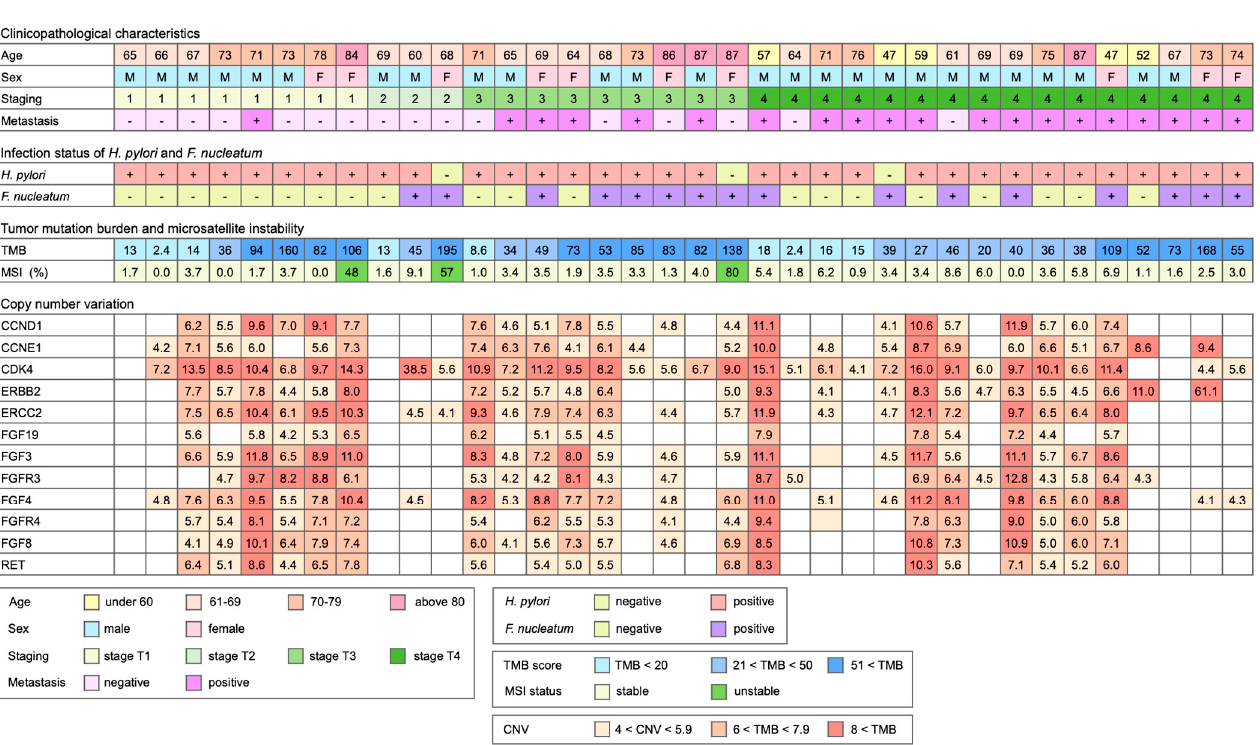
Figure 1. The clinical and pathological characteristics of the patients in this study. Resected cancer tissues from gastrectomy were analyzed using TruSight Oncology 500 DNA panel. Tumor mutation burden, microsatellite instability, and copy number variation calculated by TSO500 local app are listed. TMB represents the number of somatic variants per megabase of targeted region, and micro-satellite represents the percentage of unstable sites over all identified microsatellite sites. Copy number variation represents the copy number calculated by the analysis algorithm.